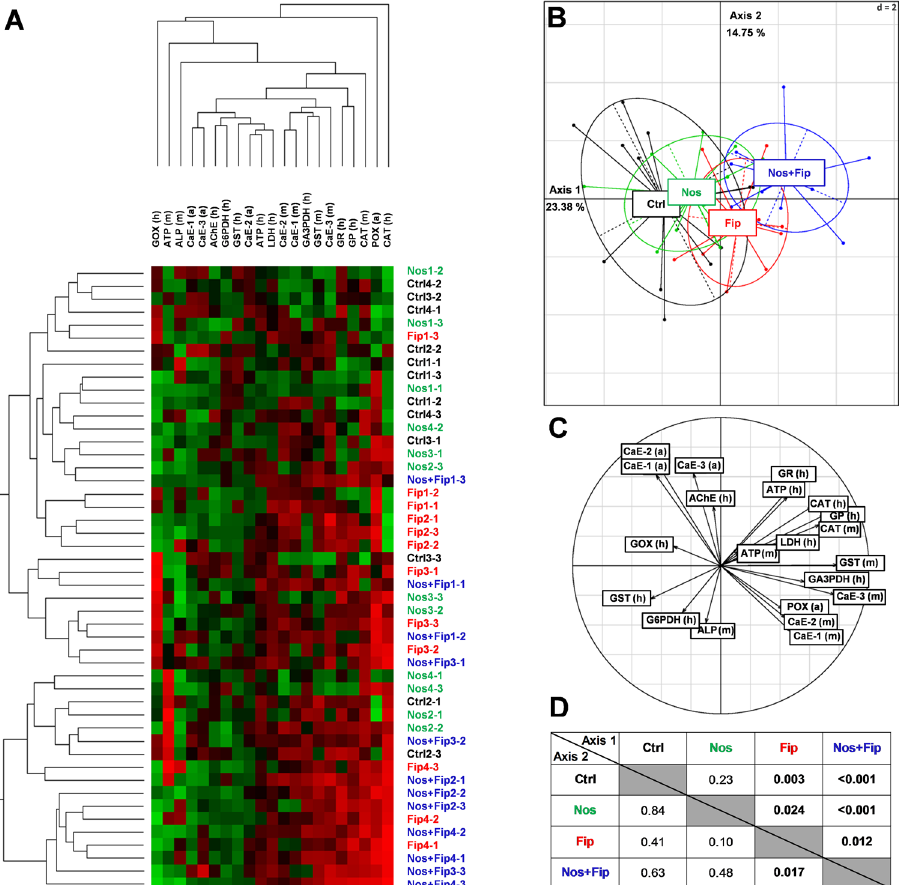
Figure 3. Effects of the stressors, alone or combined, on the physiological state of drones. According to the stressor, cluster analysis (hierarchical clustering results) after optimal reorganization 100 ( A ) and principal component analysis ( B ) show a global approach of changes to the physiological markers in the head (h), midgut (m) and abdomen (a) of drones. A color code is assigned to each treatment: “black” for the control group (Ctrl), “green” for the N. ceranae group (Nos), “red” for the fipronil group (Fip), and “blue” for the N. ceranae /fipronil group (Nos + Fip). In the cluster analysis, the first number indicates the hive, and the second number indicates the sample. The intensity of modulation in the clusters is illustrated by the range of colors, with green and red indicating that a physiological marker was downregulated or upregulated, respectively, in comparison with the mean value in the controls. Black indicates no change in comparison with the mean value in the controls. The correlation circle ( C ) indicates the significance of the markers in the PCA representation. For statistical analysis, a post-hoc Wilcoxon test was applied to the values of the two main axes of the PCA. P values are indicated in the table ( D